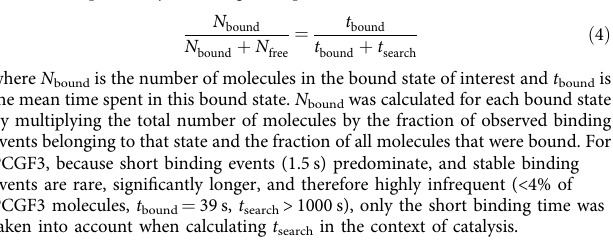
where y is the fraction of molecules remaining at time t , time t 1 represents the fi rst time point, A is the fraction of molecules with mean dwell time τ 1 , and 1 – A is the fraction of molecules with mean dwell time τ 2 . In order to estimate binding times from these measurements, mean survival times were corrected for events that result in loss of tracks from reasons other than unbinding, such as photobleaching of dye molecules or diffusion of chromatin out of focus 72 – 75 . This was done by measuring the survival time for H2B-HaloTag, which is stably bound for hours and will therefore only rarely be observed to unbind, with all other tracks being limited by photobleaching or chromatin diffusion. The survival time of H2B-HaloTag, t bleach (typically approximately 50 s), was measured for each experiment to account for changes in imaging conditions. Binding times were calculated from fi tted dwell time constants as follows: t dwell ´ t bleach ð 3 Þ t bound ¼ t bleach (cid:2) t dwell When t dwell exceeded t bleach , or was close enough to t bleach such that t bound was more than double t bleach , binding times were not estimated and are indicated as likely exceeding 100 s. Estimated stable binding times and fractions of observed binding events which were stable for PRC1 subunits are given in Supplementary